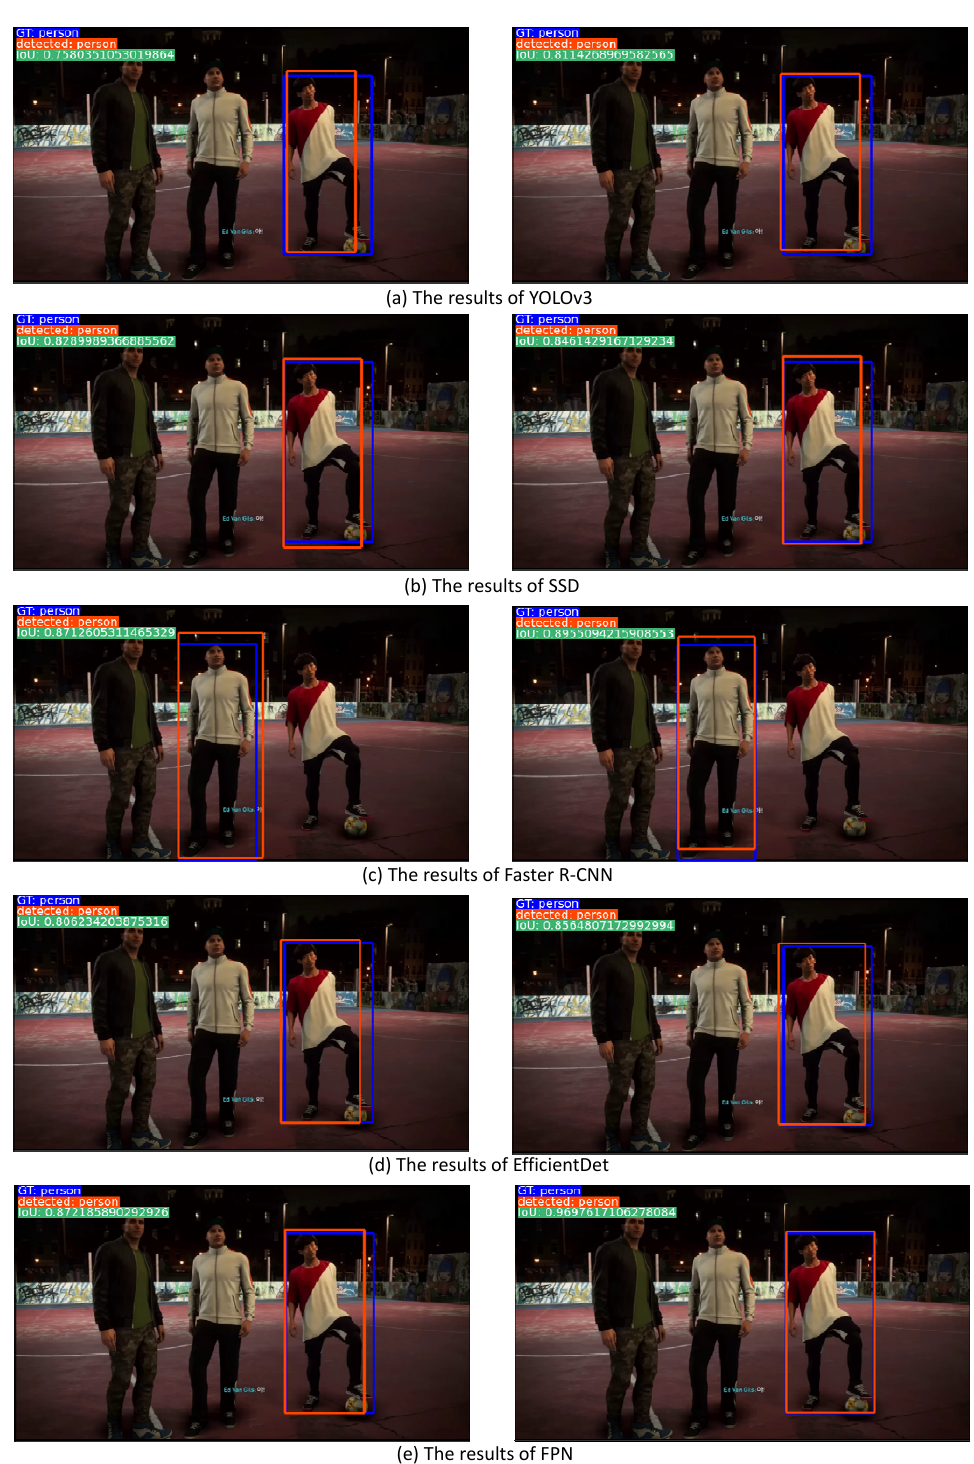
Figure A5. Comparison of the bounding box detection on game FIFA 20. The left column is the result from the models trained by PASCAL VOC and the right column is the result from the models trained by PASCAL VOC and game